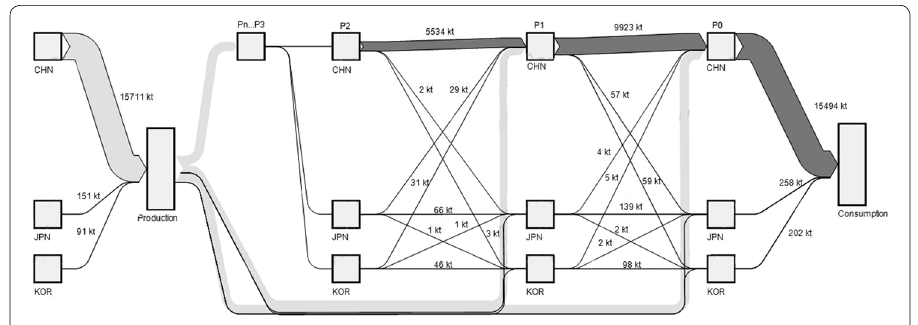
Fig. 1 Sankey diagram of PM2.5 emission (in